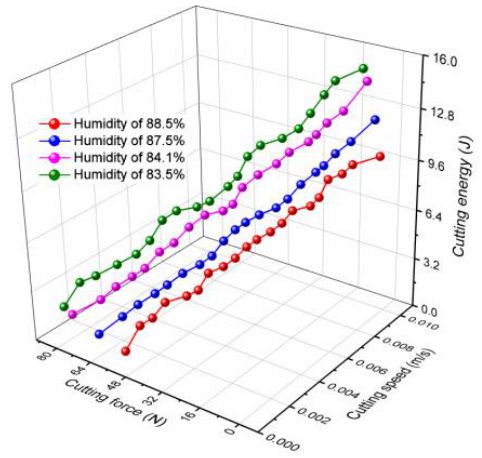
Figure 4. Variation in cutting energy for peeled apples with different humidity levels as a function of cutting speed.